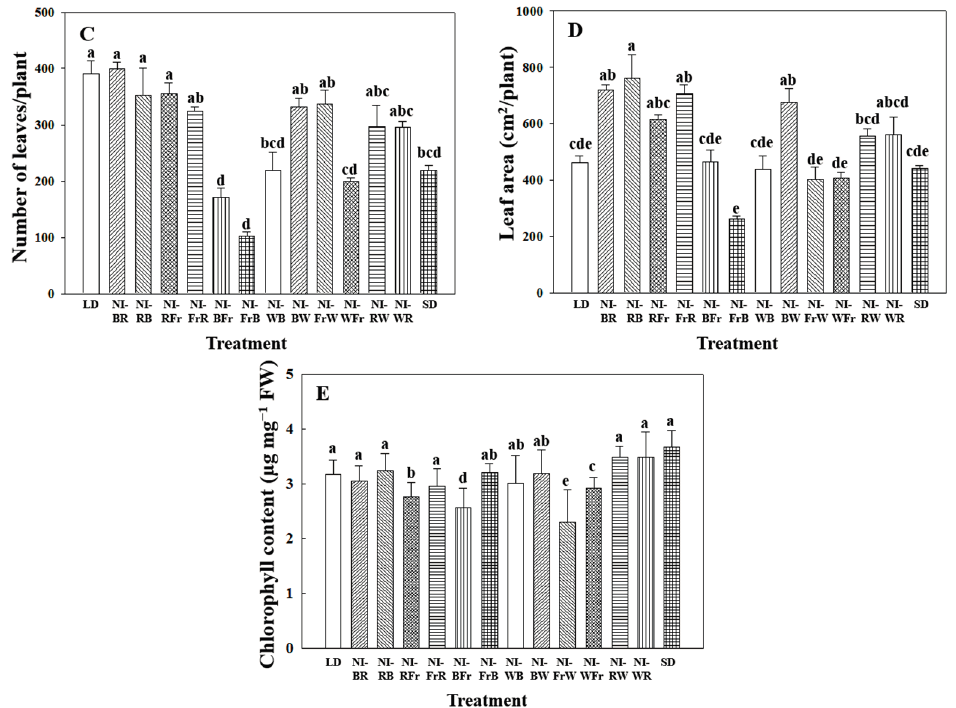
Figure 1. Effects of the shifts in the light quality of night interruption (NI) on ( A ) plant height; ( B ) dry mass; ( C ) Number of leaves per plant; ( D ) leaf area; and ( E ) chlorophyll content in Dendranthema grandiflorum “Gaya Yellow” (Please refer to Figure 1 for details of light quality of NI). Vertical bars indicate ± S.E of the means for n = 3. Means accompanied by different letters are significantly different ( p < 0.05) according to the Tukey’s studentized range